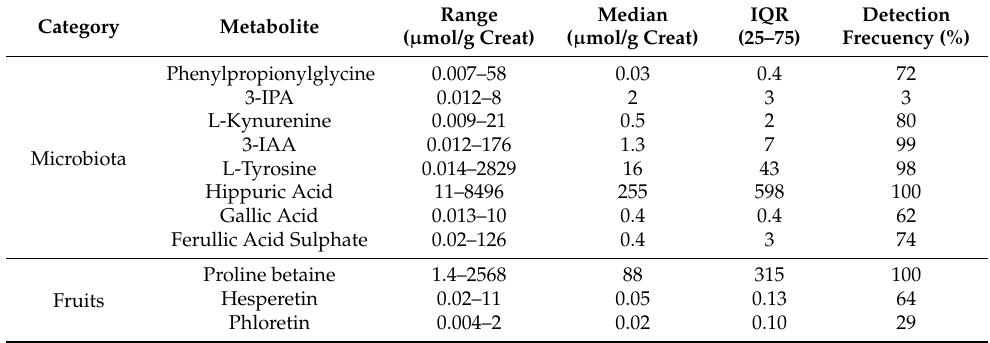
Table 2. Microbiota and nutrition biomarker concentrations in urine samples from lactating